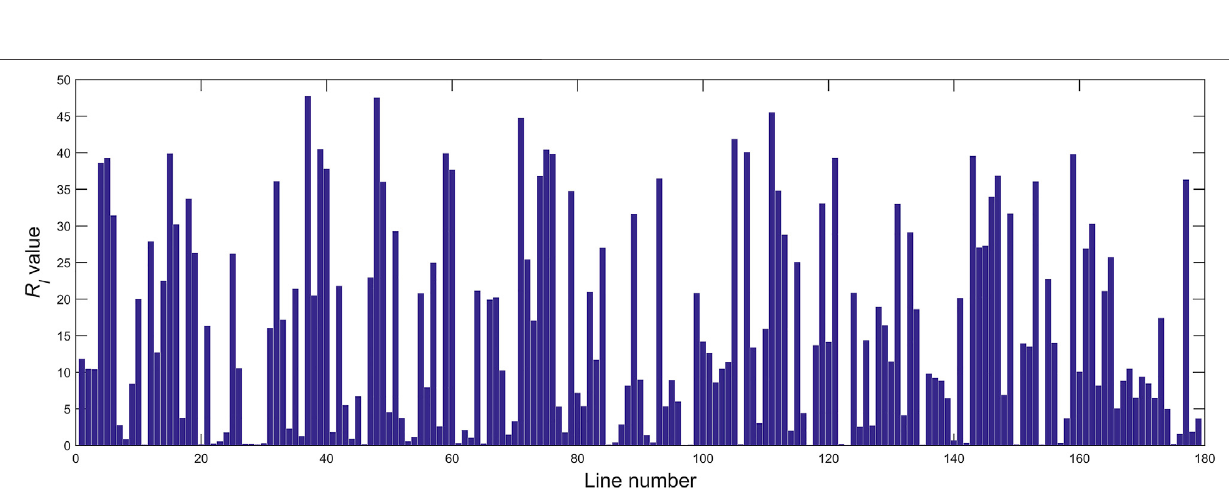
FIGURE 5 | R l value of the IEEE-118 bus power system.